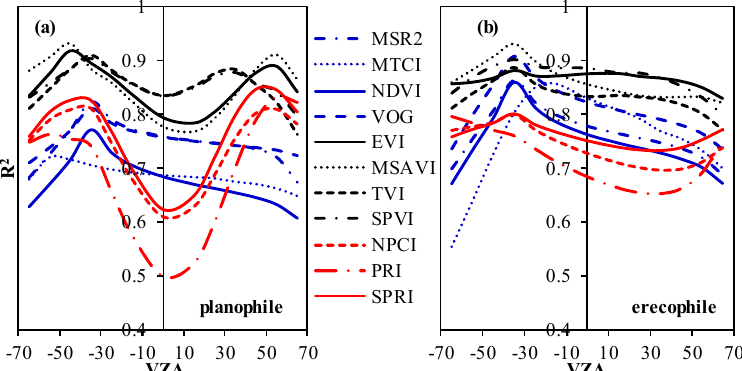
Figure 8. R 2 of the linear relationships between the LAI and selected VIs at different VZAs in PP for ( a ) the erectophile and ( b ) the planophile varieties based on PROSAIL simulations.